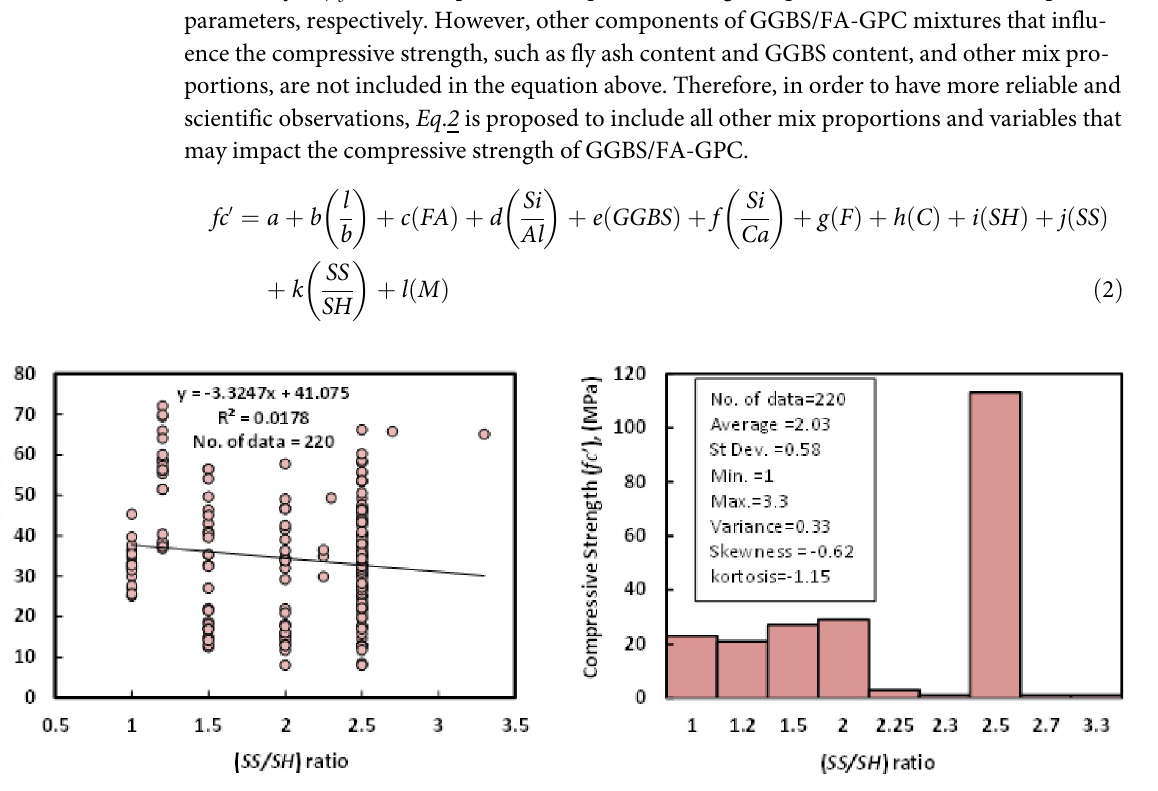
Fig 11. Relationship and a histogram of compression strength and (SS/SH) ratio of GGBS/FA-GPC.